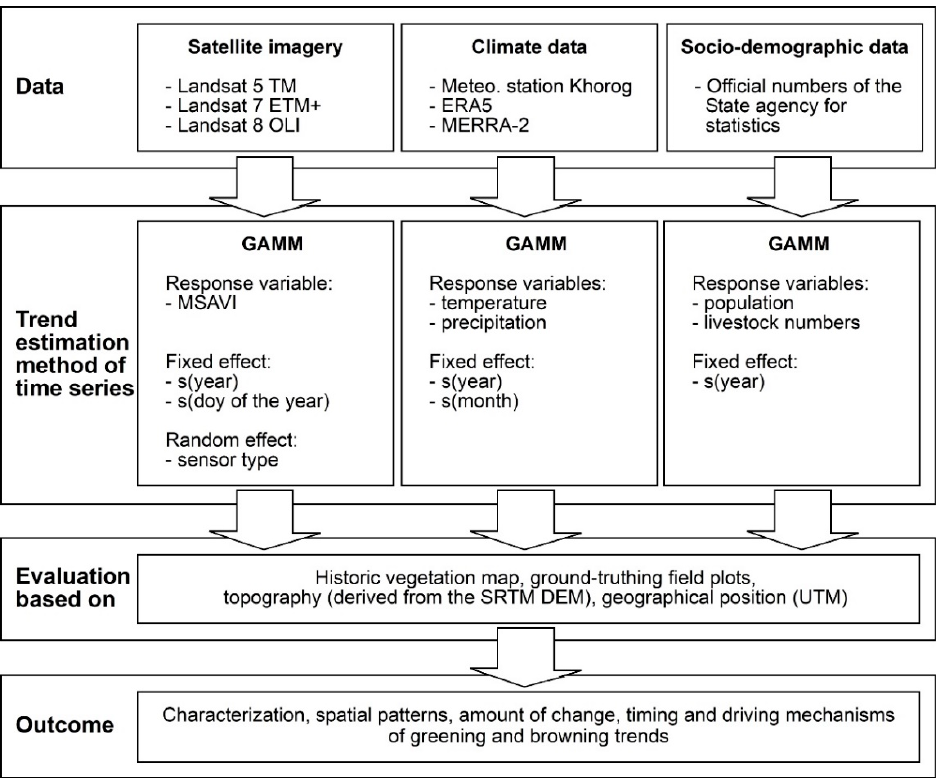
Figure 1. General workflow of the study.